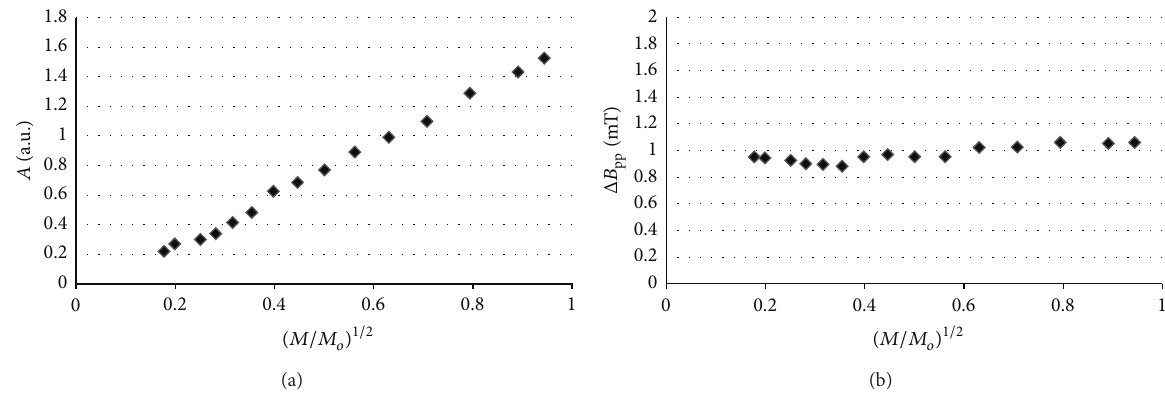
Figure 11: The effect of microwave power on (a) amplitude ( 𝐴 ) and (b) line width ( Δ𝐵 sterilized at 170 ∘ C (60 minutes). 𝑀 —microwave power used during the measurement of the EPR spectra, 𝑀 𝑜 —total microwave power produced by klystron (70 mW).